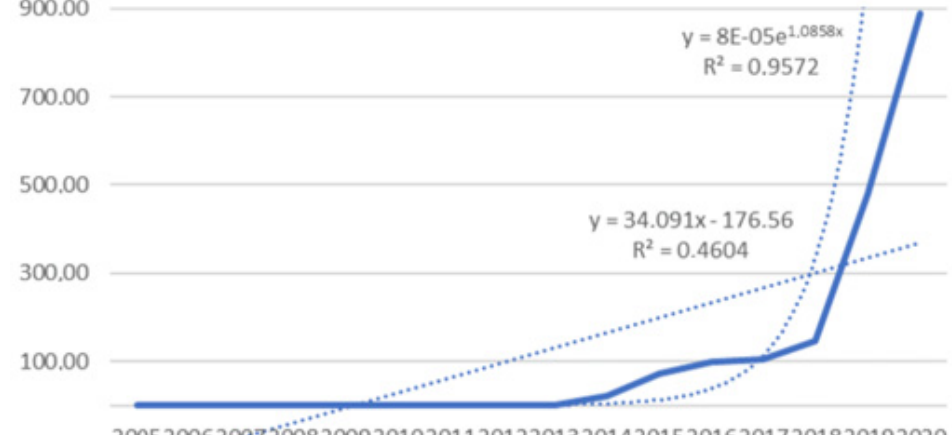
Figure 7. Photovoltaic systems—installed capacity (MW) and trends.